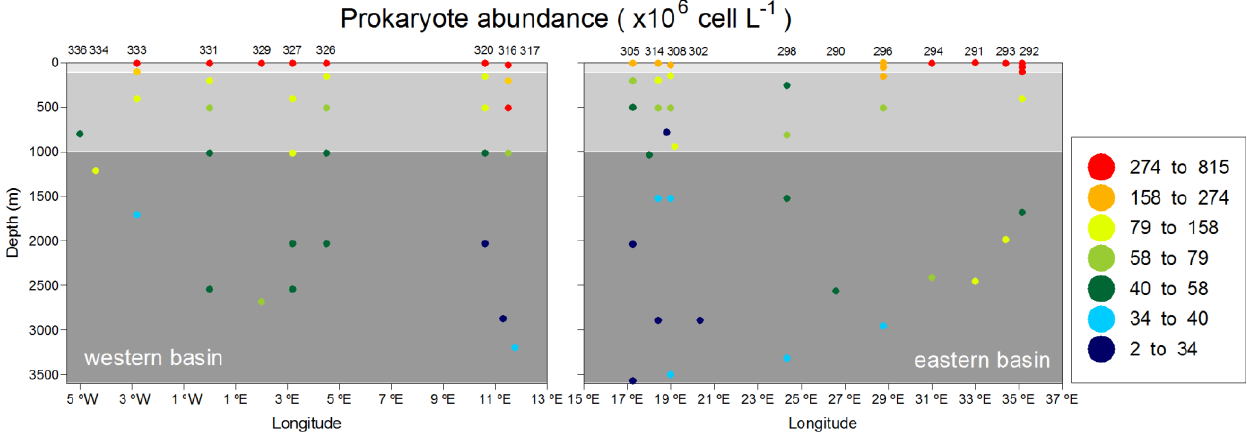
Fig. 2. Prokaryotic abundance across the water column in the eastern and western Mediterranean Sea. Prokaryotic abundance in each of the three water layers (epi-: ≤ 100m; meso-: 100–1000m; and bathypelagic: > 1000m) in the eastern and western basin of the Mediterranean Sea during the Meteor cruise. Station name labels are reported only for those stations where prokaryotic abundance was evaluated at two or more depths.The figure was generated by SURFER 11- Golden Software.